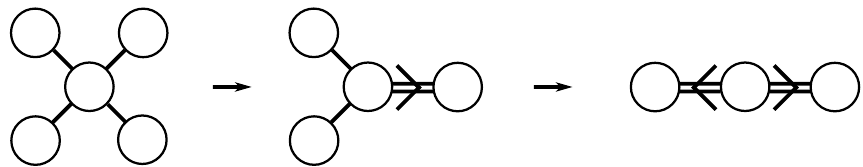
Figure 9. The change of the Dynkin diagram after the Higgsings of (2 , 2 , 0 , 0) and then the Higgsing of (0 , 0 , 2 , 2)